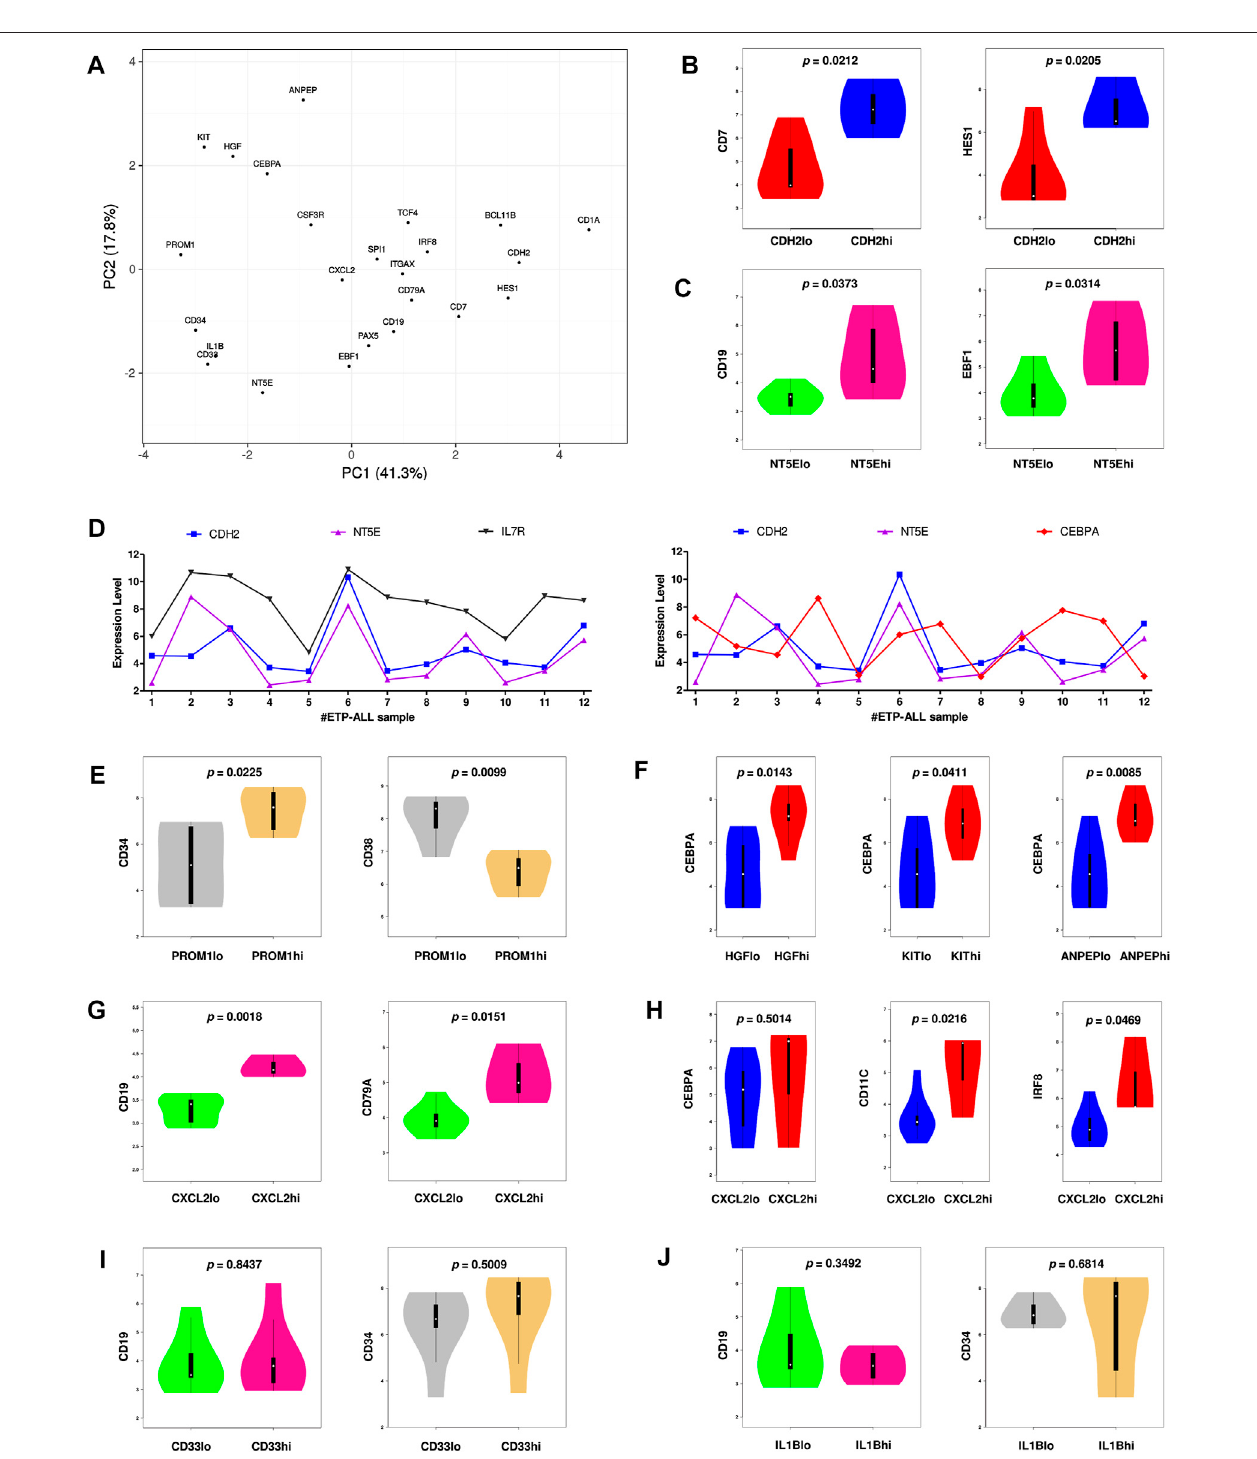
FIGURE6| Inclinationoftheproposedbiomarkerstowardsdifferenthematopoieticlineages. (A) Principalcomponentanalysis(PCA)plotofnormalizedexpression scores (from GSE28703) of the hub genes along with standard markers of hematopoietic lineages. Lineage af fi liation of the known markers are as follows; CD34: stemness;CEBPA,CSF3R:myelo-monocytic;EBF1,PAX5,CD19,CD79A:B-lineage;CD7,HES1,BCL11B,CD1A:T-lineage;SPI1,ITGAX,IRF8,TCF4:dendriticcells. (B) ExpressionofCD7andHES1alongwithdifferentlevelsofCDH2. (C) ExpressionofCD19andEBF1alongwithdifferentlevelsofNT5E. (D) ExpressionofCDH2, NT5E, IL7R, and CEBPA across different ETP-ALL samples from GSE28703. (E) Expression of CD34 and CD38 along with different levels of PROM1. (F) Expression of CEBPA alongwith different levels ofHGF, KITand ANPEP. (G) Expressionof CD19and CD79Aalongwith different levels ofCXCL2. (H) Expression ofCEBPA, CD11C, andIRF8alongwithdifferentlevelsofCXCL2. (I) ExpressionofCD19andCD34alongwithdifferentlevelsofCD33. (J) ExpressionofCD19andCD34alongwithdifferent levels of IL1B. Two-tailed unpaired Student ’ s t-test was used to compute the statistical signi fi cance for each comparison.